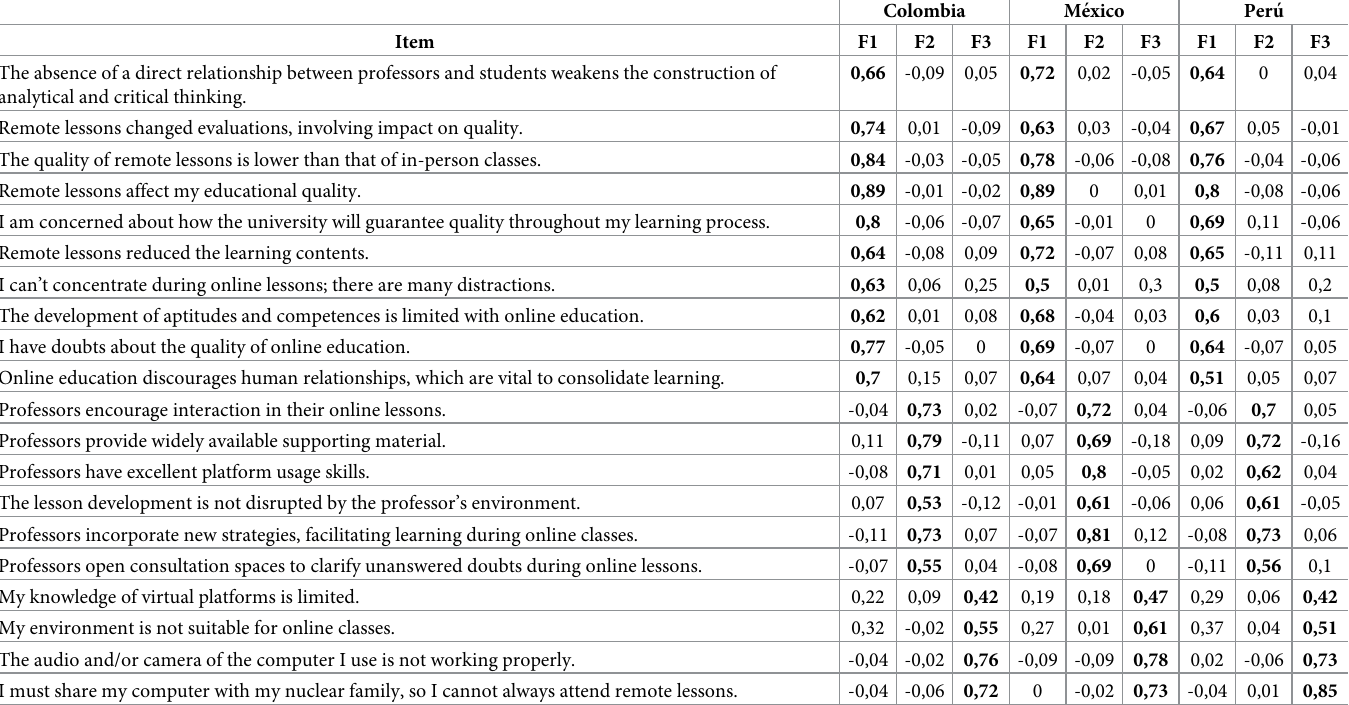
Table 5 shows the statistical description of the values measured. Scores were converted into a standardized normal score to facilitate interpretation. All correlations were statistically sig- nificant, and similar results were obtained in all countries. CEQ had a negative relationship with TSAP but a positive relationship with PAL. Participants indicate that in situations wherein they could perceive better planning and implementation of training activities by lec- turers, their concerns about the educational quality have diminished. Nonetheless, the oppo- site happened when greater access constraints were suffered by them. On the other hand, TSAP had a negative relationship with PAL. The lecturer’s active role in activity planning and implementation has helped mitigate the perceived challenges to access education.